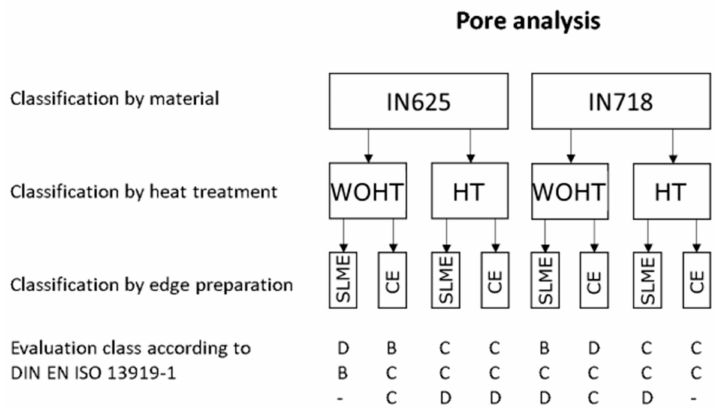
Figure 9. Results of quality evaluation in accordance with DIN EN ISO 13919-1